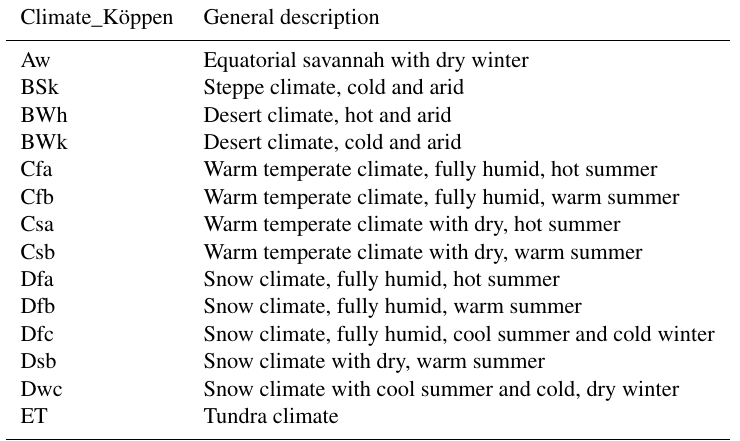
Table 2. Description of the Köppen–Geiger climate classification types at all the selected ISMN